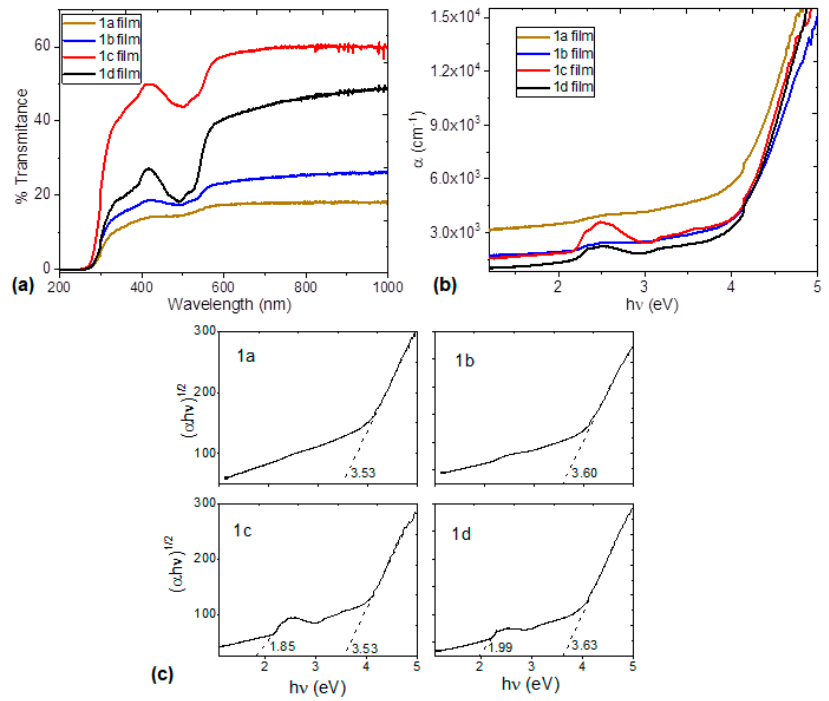
Figure 6. ( a ) Transmittance spectra, ( b ) absorption coefficient spectra and ( c ) Tauc plots of hybrid films.